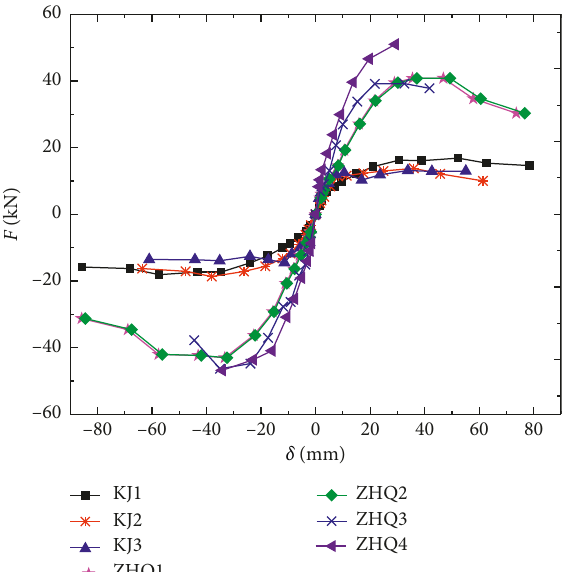
Figure 14: Skeleton